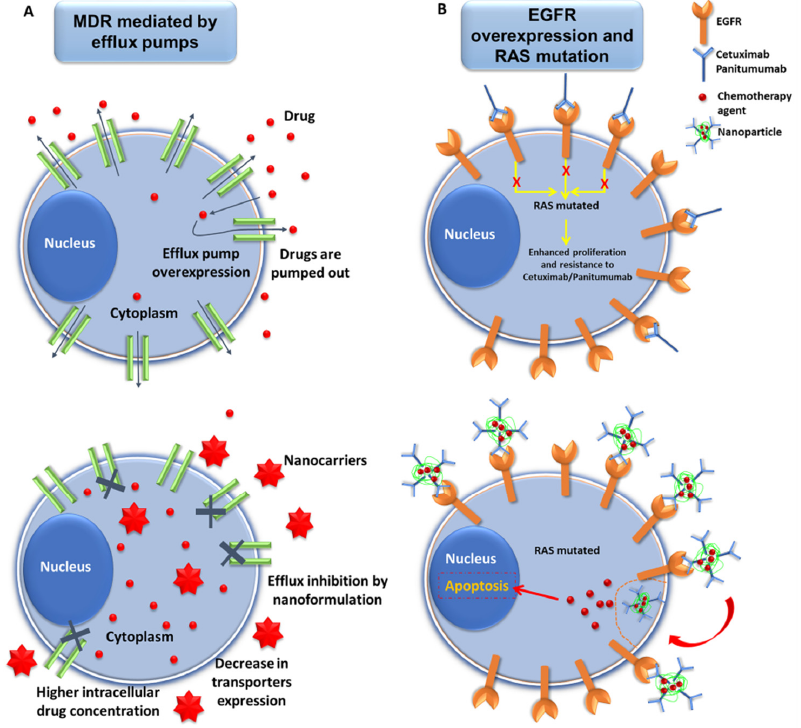
Figure 1. Representative scheme of nanomedicine strategies against drug resistance in pancreatic cancer. ( A ) Interactions of nanoformulations with MDR mechanism in pancreatic cancer (PAC)